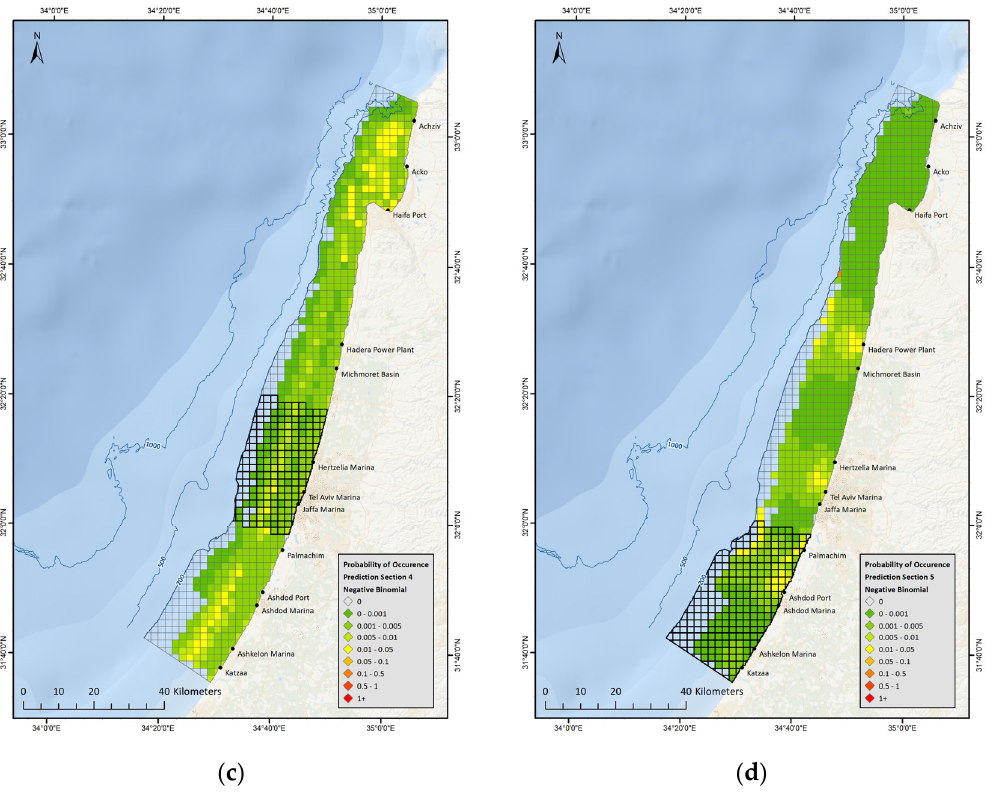
Figure 4. ( a ) Prediction Map for T. truncatus based on Negative Binomial distribution and ‘trawler excluded’ data from Areas 3, 4 and 5; ( b ) Prediction Map for T. truncatus based on Tweedie distribution and ‘trawler excluded’ data from Areas 3, 4 and 5; ( c ) Prediction Map for T. truncatus based on Negative Binomial distribution and ‘trawler excluded’ data from ‘Area 4’; ( d ) Prediction Map for T. truncatus based on Negative Binomial distribution and ‘trawler excluded’ data from ‘Area 5’.